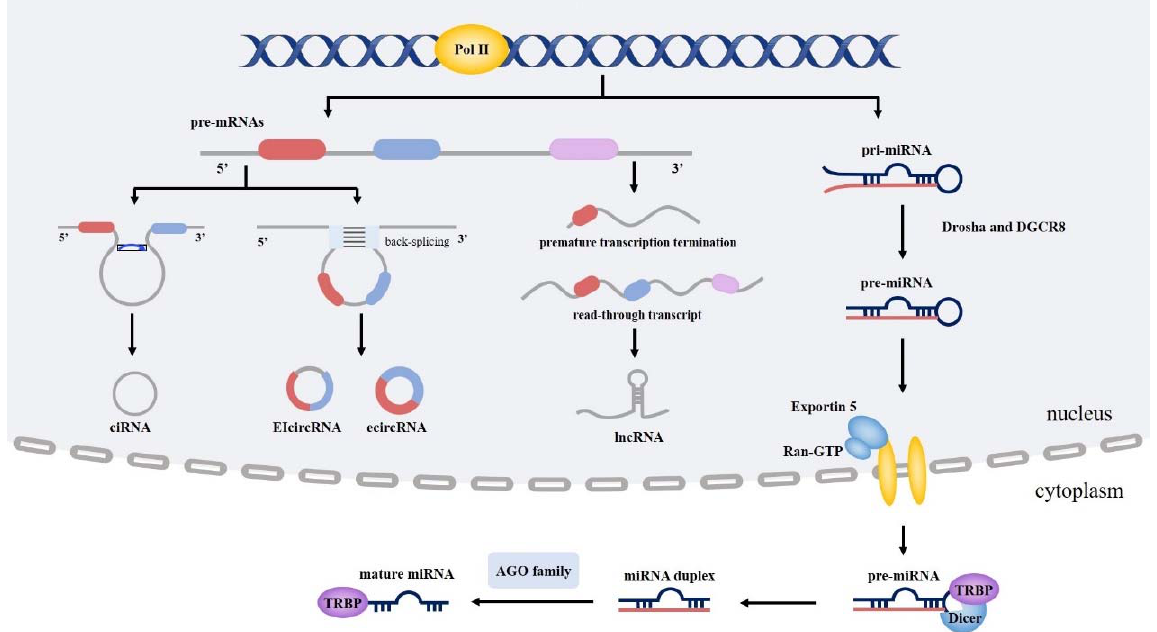
Figure 1. Biogenesis of ncRNAs. Abbreviations: AGO, argonaute; circRNA, circular RNA; ciRNA, intronic circRNA; ecircRNA, exonic circRNA; EIciRNA, exon–intron circRNA; lncRNA, long non- coding RNA; miRNA, microRNA; ncRNA, non-coding RNA; Pol II, RNA polymerase II; TRBP, TAR RNA binding